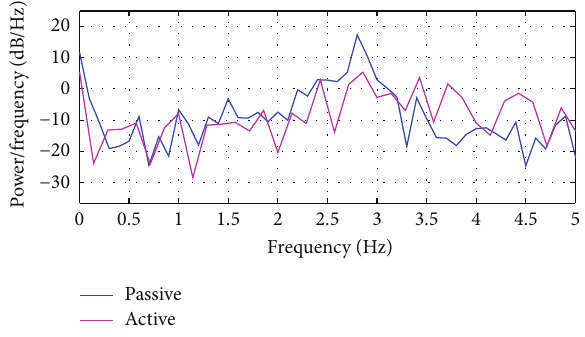
Figure 12: The PSD of unsprung mass